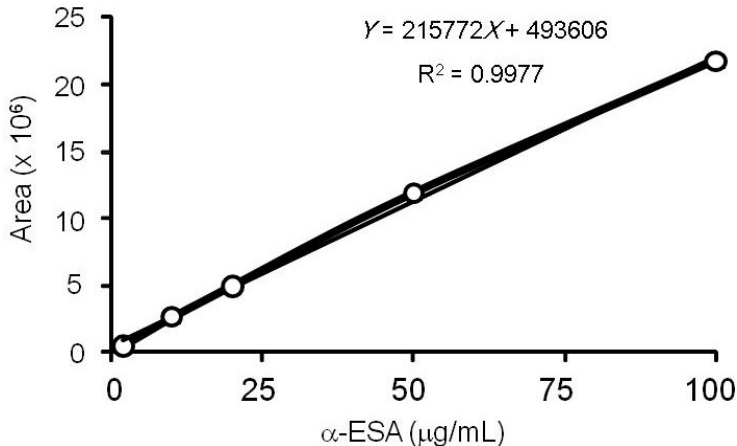
Figure 2. Calibration curve of α-ESA.